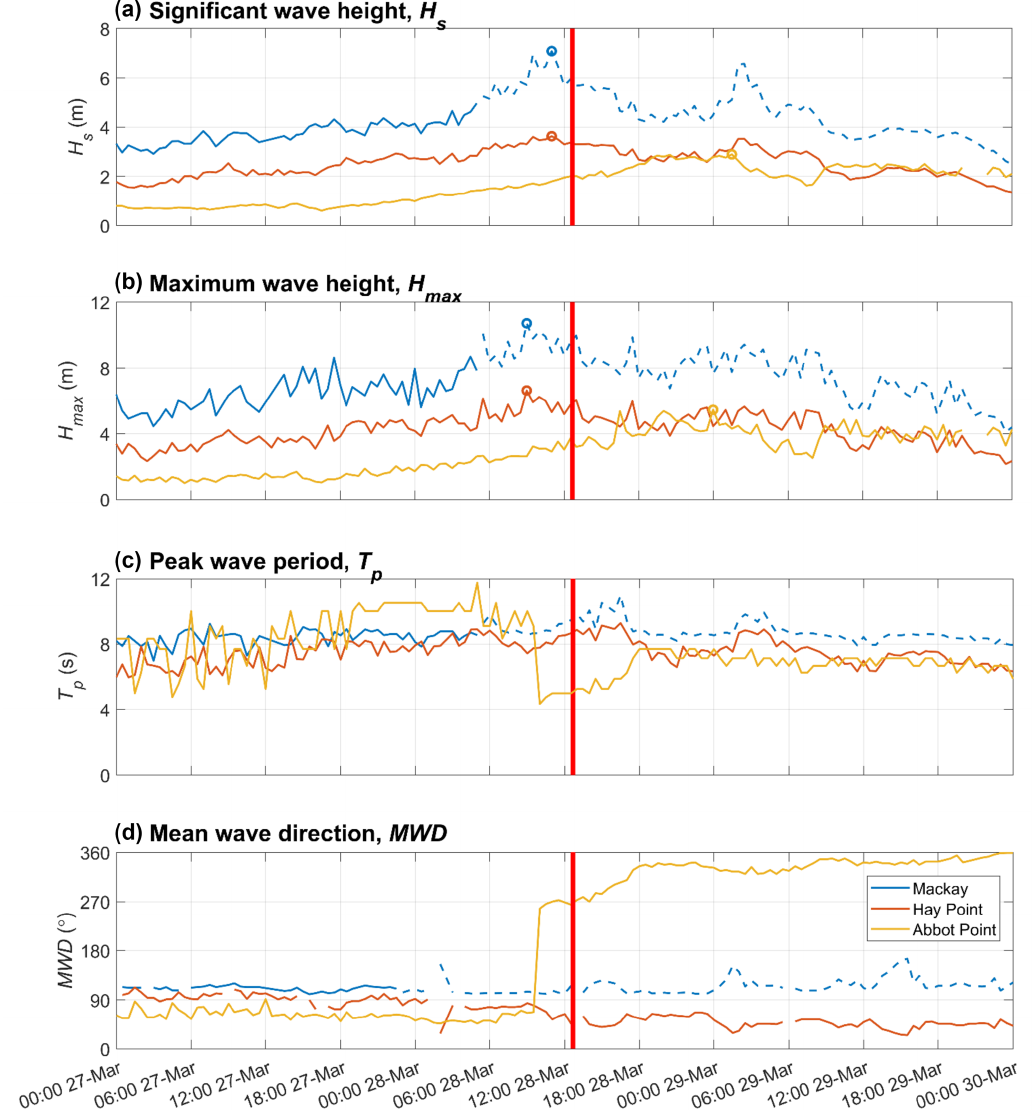
Figure 5. Wave observations during Debbie at (north to south) Abbot Point, Mackay and Hay Point wave buoys. Parameters shown are (a) significant wave height, H s , (b) maximum wave height, H max , (c) peak wave period, T p , and (d) mean wave direction, MWD. Red vertical line indicates approximate time of landfall at Airlie Beach. Dotted blue line indicates the extrapolated estimate of wave conditions at Mackay, after the failure of the wave buoy at 05:30 on 28 March. Maximum H s and H max at each buoy are also shown in (a) and (b) , respectively